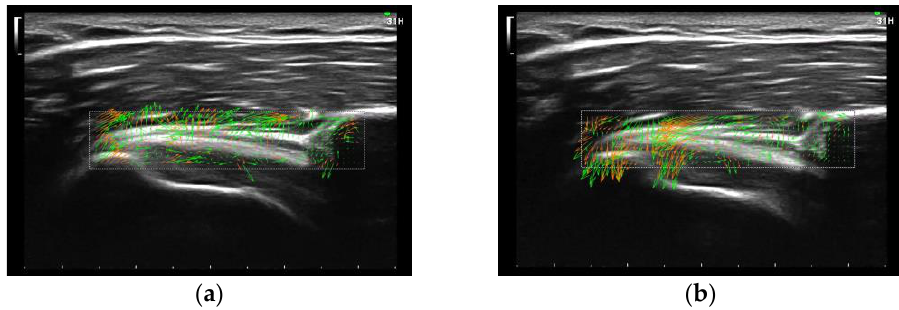
Figure 6. Flow PIV fluid measurement software of CHL movement ( a ) in internal rotation and ( b ) in external rotation. The direction of the arrow indicates the direction in which the particle moves.